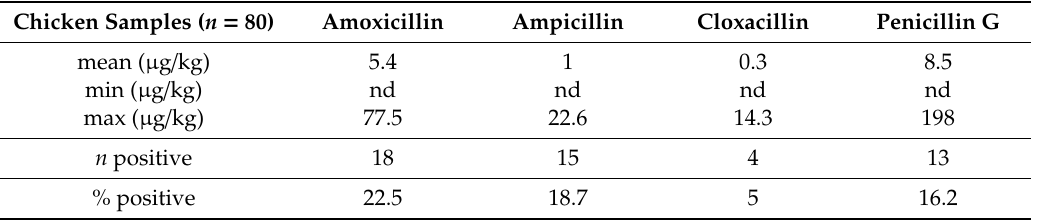
Table 7. Occurrence in the 80 chickens samples of β